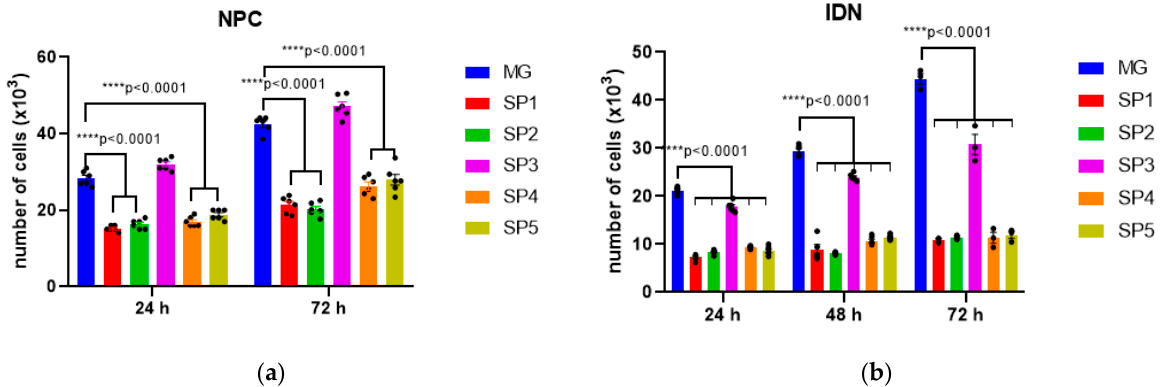
Figure 3. Proliferative activity of cells cultured on different CC variants 24, 48, and 72 h after seeding. ( a ) NPC, ( b ) IDN. Individual repeat values in the histogram are indicated by black dots. Mean ± SEM, N = 3–6. One-way ANOVA followed by Dunnett’s post hoc test. **** p < 0.0001 compared with MG.